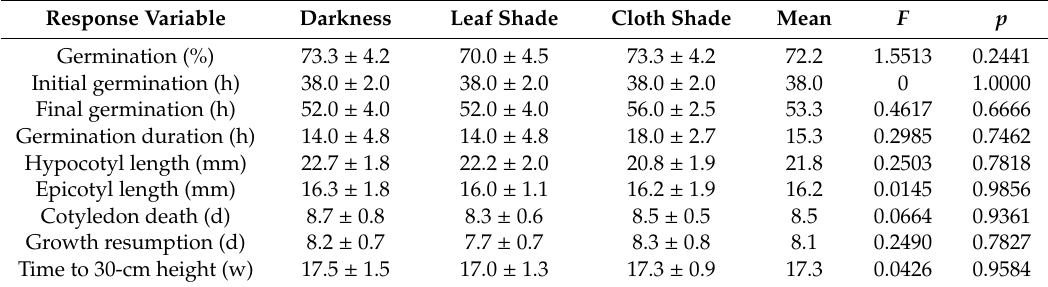
Table 2. The influence of exposing germinating Serianthes nelsonii seeds to darkness, low red:far red light of 64 µ mol / m 2 / s (0.21; shade by Ochrosia oppositifolia leaf), or high red:far red light of 61 µ mol / m 2 / s (1.14; shade by cloth) on germination and seedling traits. Mean ± standard error. Six replications, five seeds each.